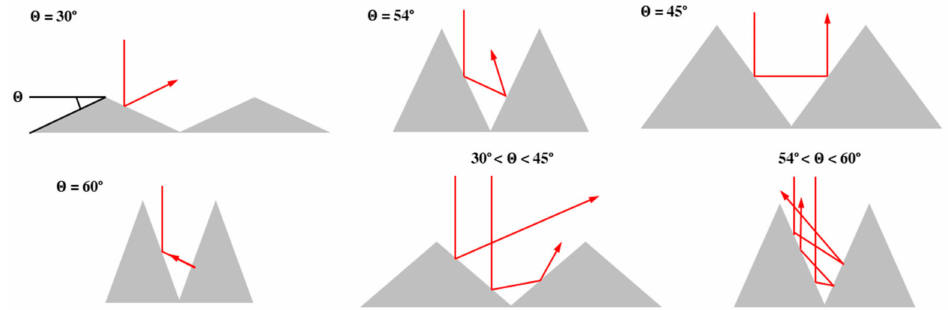
Figure 1. The path of light incident on the V-shaped surface according to